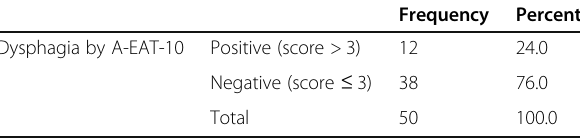
Table 5 The frequency and percentage of dysphagia by Arabic EAT-10 in all participating patients